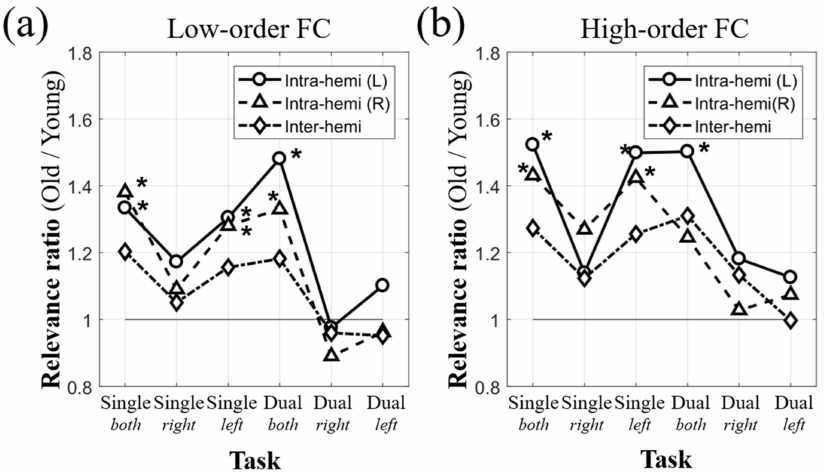
Figure 6. Ratios of the relevance values between the elderly and younger adult groups for ( a ) LoFC and ( b ) HiFC. Relevance values were averaged over all brain regions and frequency ranges. Solid lines marked by circles and dashed lines marked by triangles represent the relevance ratios of intra-hemispheric FC in the left and right hemispheres, respectively. The relevance ratios in inter- hemispheric connectivity are indicated by the dash-dotted line with diamond marks. The asterisks show the significant difference in relevance ratios between the younger and older groups (two-sample t -test, p <